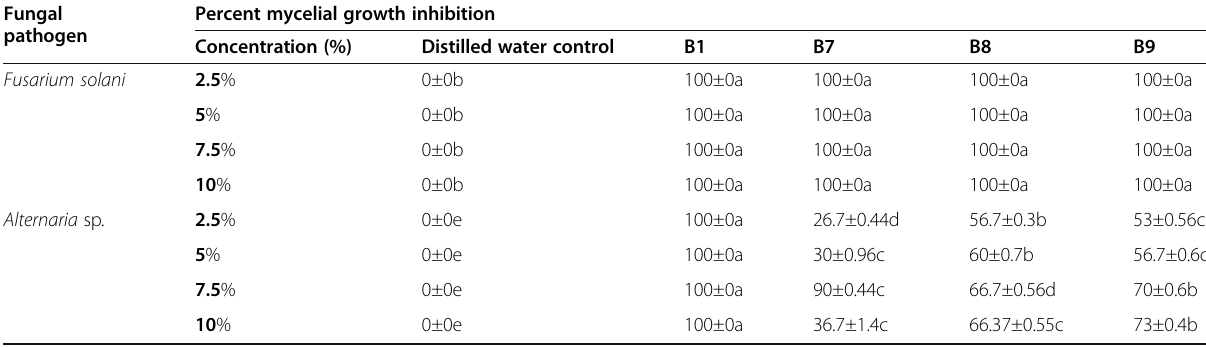
Table 2 Antifungal activity of cell-free culture supernatants of endophytic bacteria against Fusarium solani and Alternaria sp . as assessed by poisoned food technique Fungal Percent mycelial growth inhibition pathogen Concentration (%) Distilled water control B1 B7 B8 B9 Fusarium solani 2.5 % 0±0b